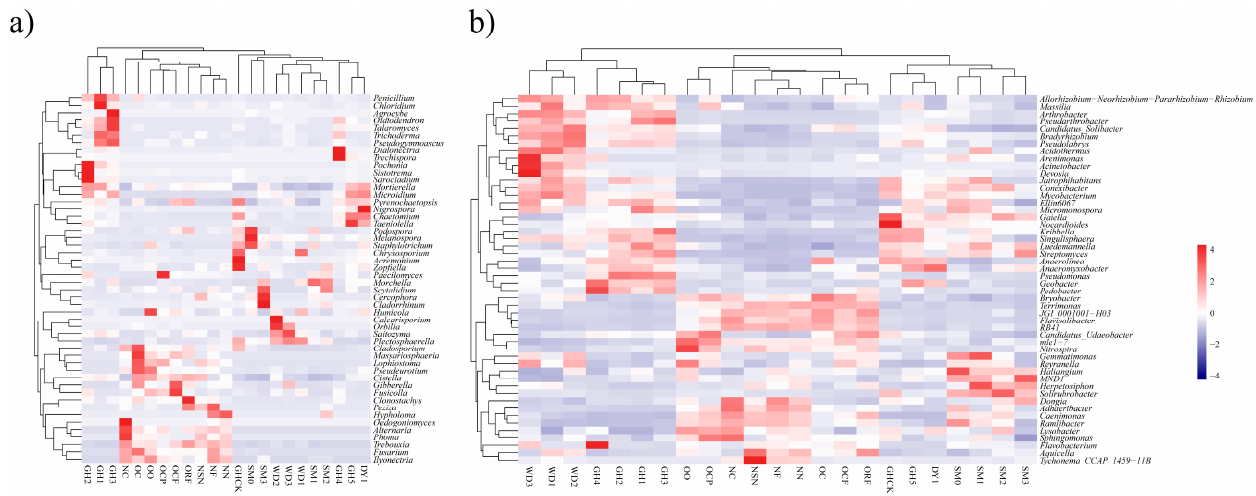
Figure 5. Heatmap of the relative abundances of top 50 fungal genera ( a ) and top 50 bacterial genera ( b ). Gradient color from blue to red represents a relative abundance of each taxon from low to high. Scale, the relative abundance of genus at row normalization by removing the mean (centering) and dividing by the standard deviation (scaling).